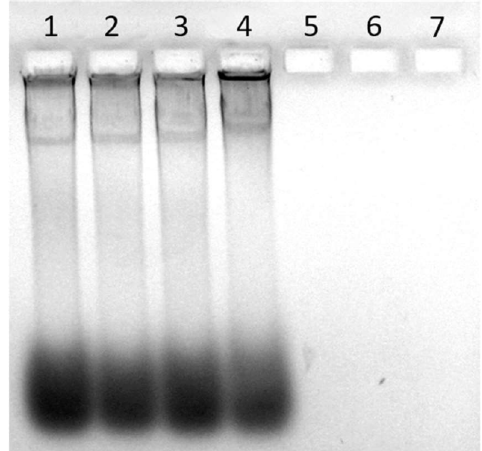
Figure 7. PHMG-1 complexes with eDNA and neutralizes the intrinsic charge of DNA molecules. Shown here is a 1.2% agarose-TA gel stained with EtBr to visualize Pseudomonas aeruginosa ATCC 27853 (PA) eDNA that had been treated with PHMG-Cl. Treatments: (1) water-only control, (2) 0.001%, (3) 0.005%, (4) 0.01%, (5) 0.05%, (6) 0.1%, and (7) 0.5%